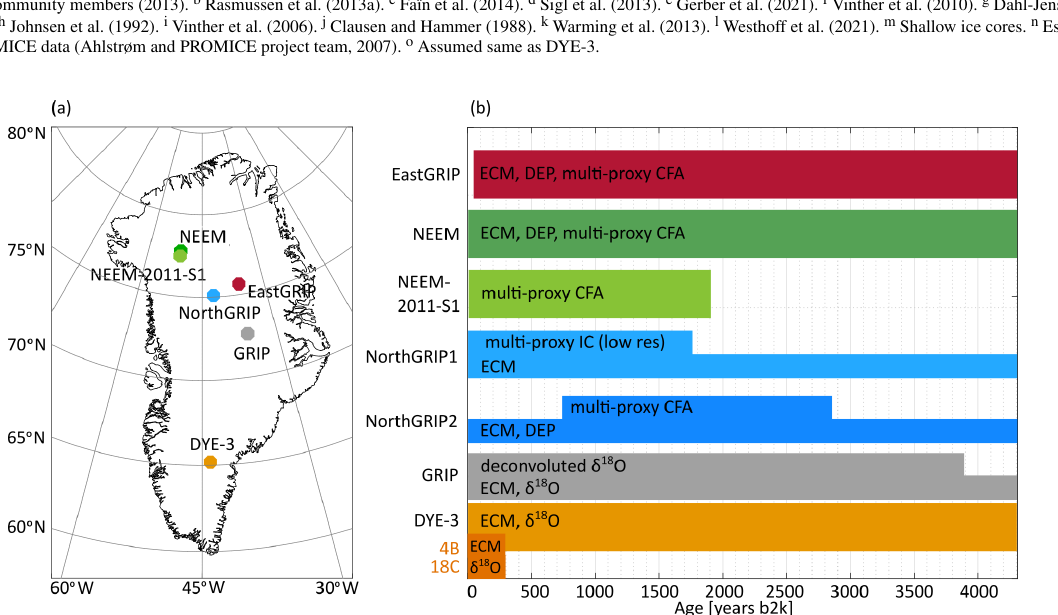
Figure 1. Overview of the data used for this study. (a) Geographic locations of the ice cores, for which Table 1 contains the site specifications. (b) The colored patches summarize the available datasets used for annual-layer counting (e.g., continuous flow analysis – CFA) and inter-core matching (e.g., ECM), plotted on their approximate age